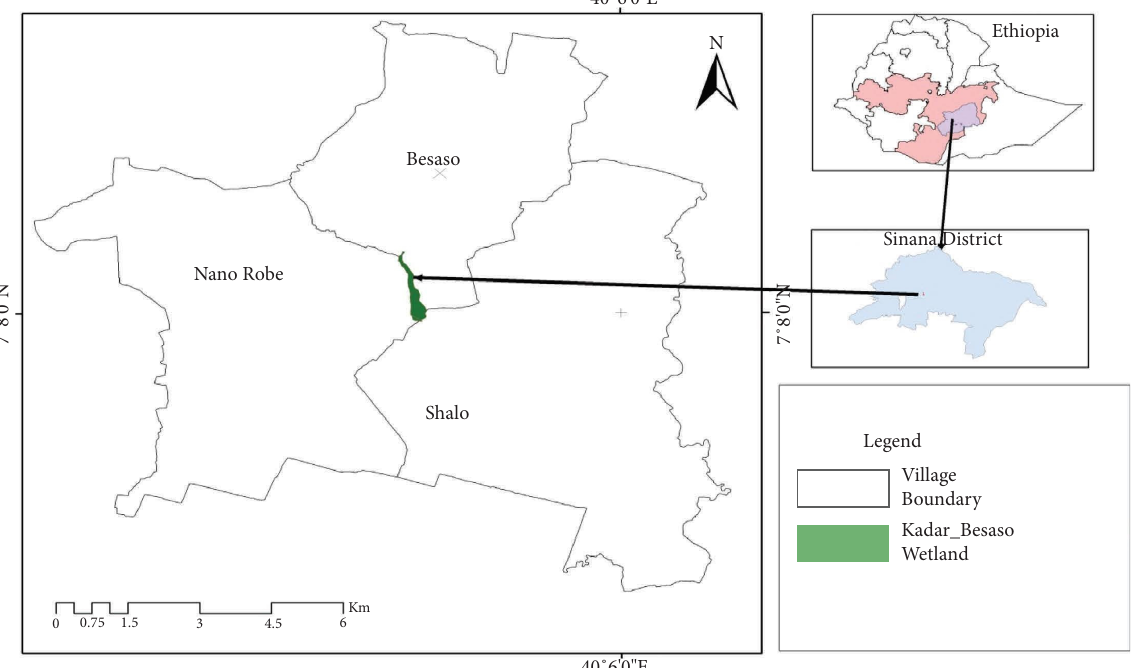
Figure 1: Location map of the study